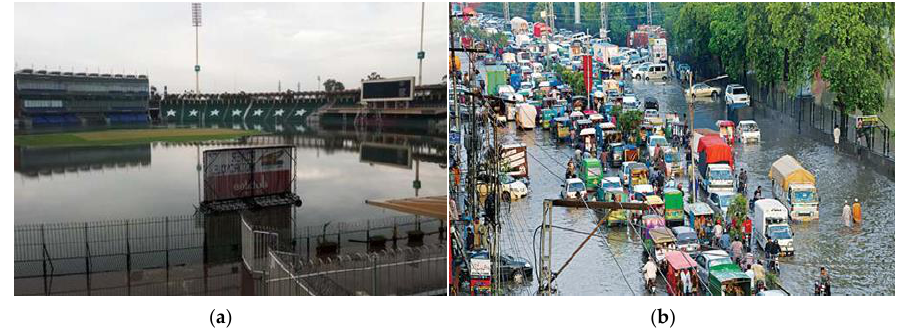
Figure 2. ( a ) Ponding condition inside Gaddafi Stadium; ( b ) a traffic mess on Circular road after rainfall (DAWN news)